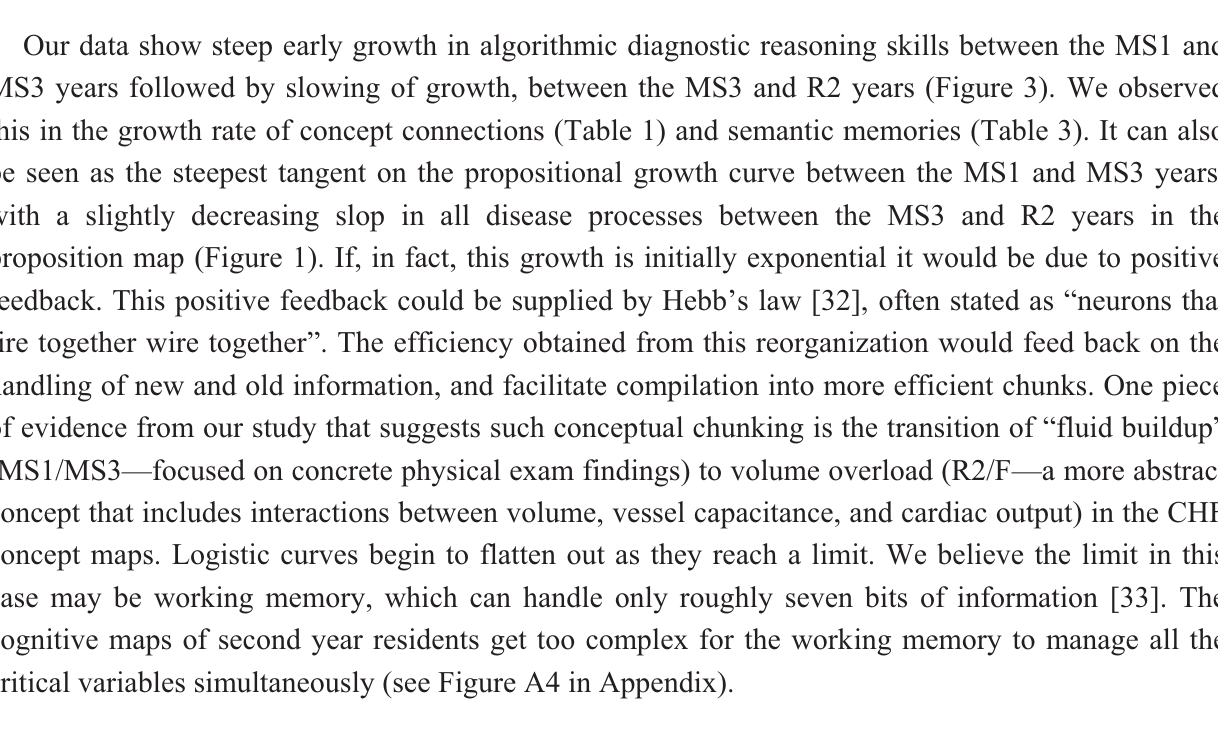
Figure 3. The logistic growth of diagnostic reasoning skills observed in intermediate